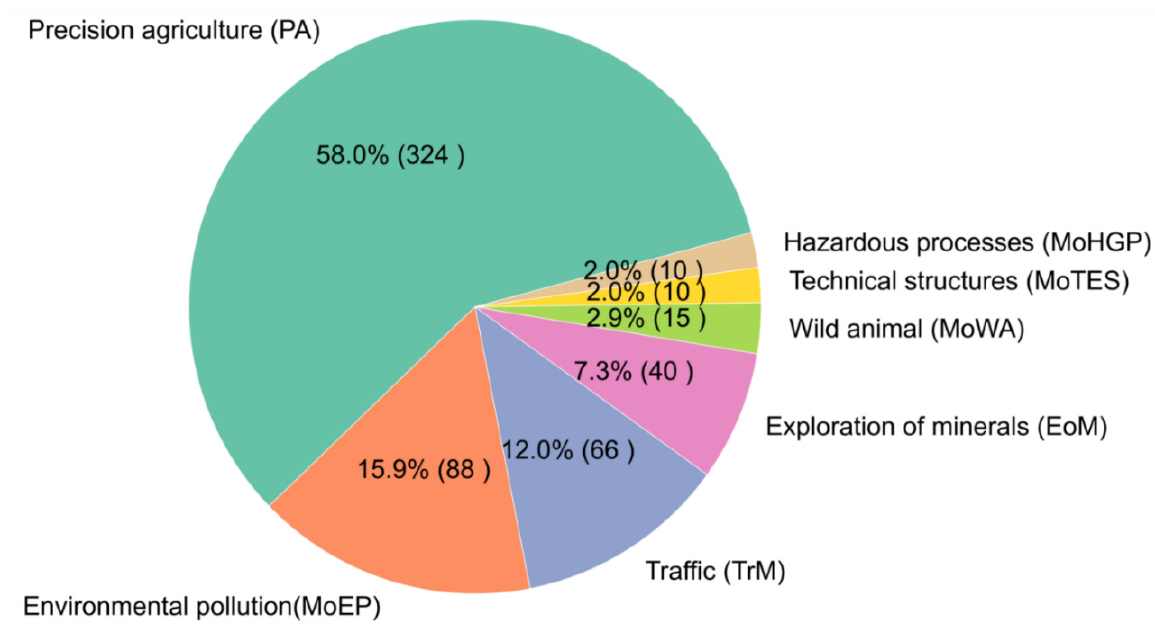
Figure 10. Comparative economic effect from the IUVAT applications. Source: Generated by the authors.